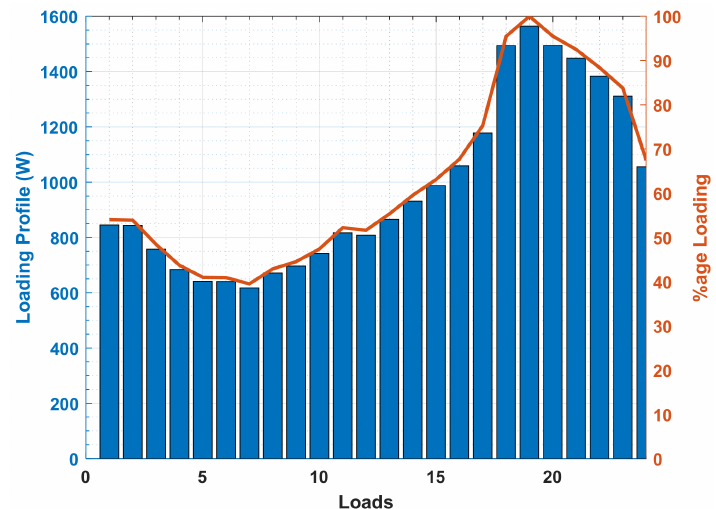
Figure 7. Load profile of DC distribution network [9].